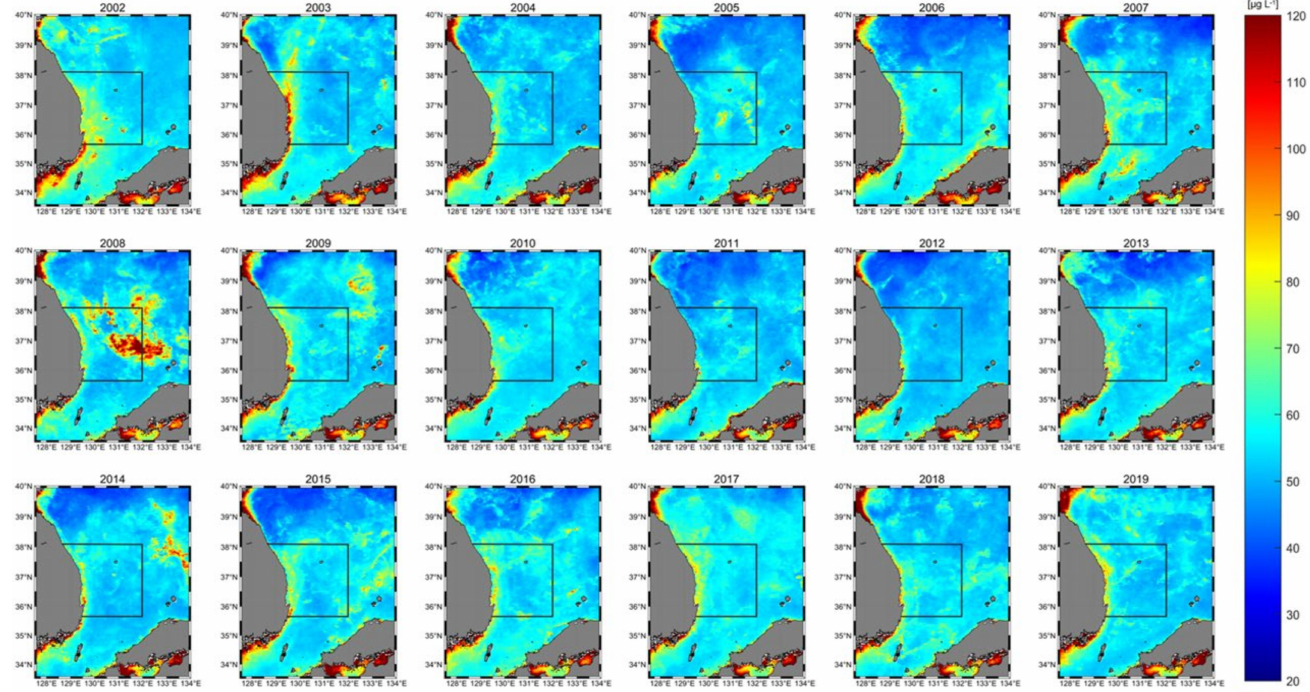
Figure 8. Long-Term pattern of the protein concentration of phytoplankton in the East/Japan Sea (EJS) from 2003 to